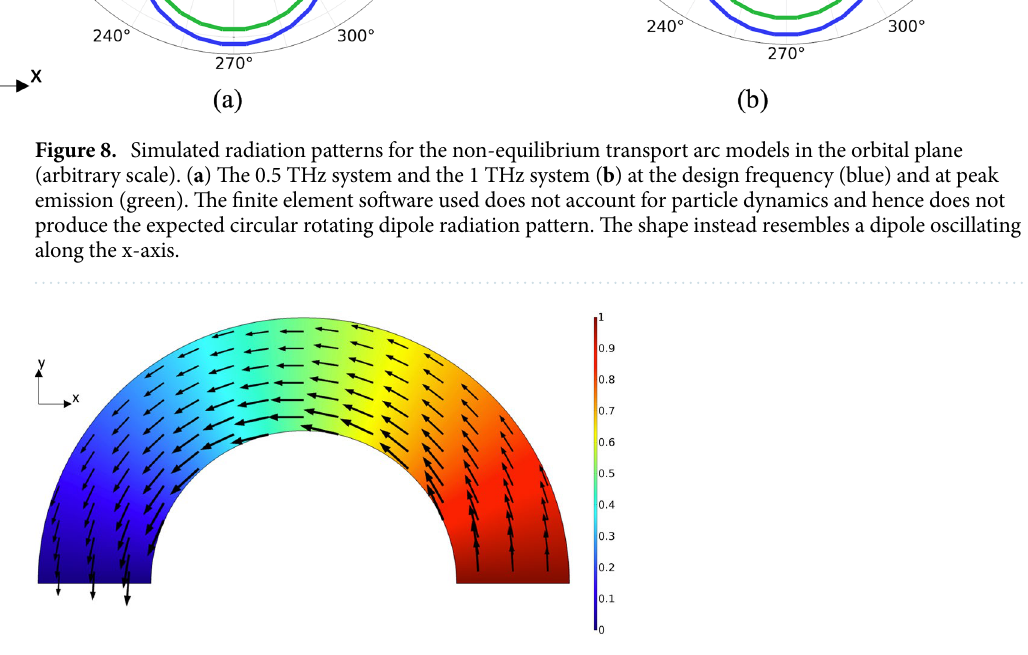
Figure 9. Simulated current density under DC bias of 1 V potential difference between source and drain. In both systems, current flows along the arc with the highest current density at the inner radius as indicated by arrow size. This is unlike the point charge assumption in which all of the charge located at the inner